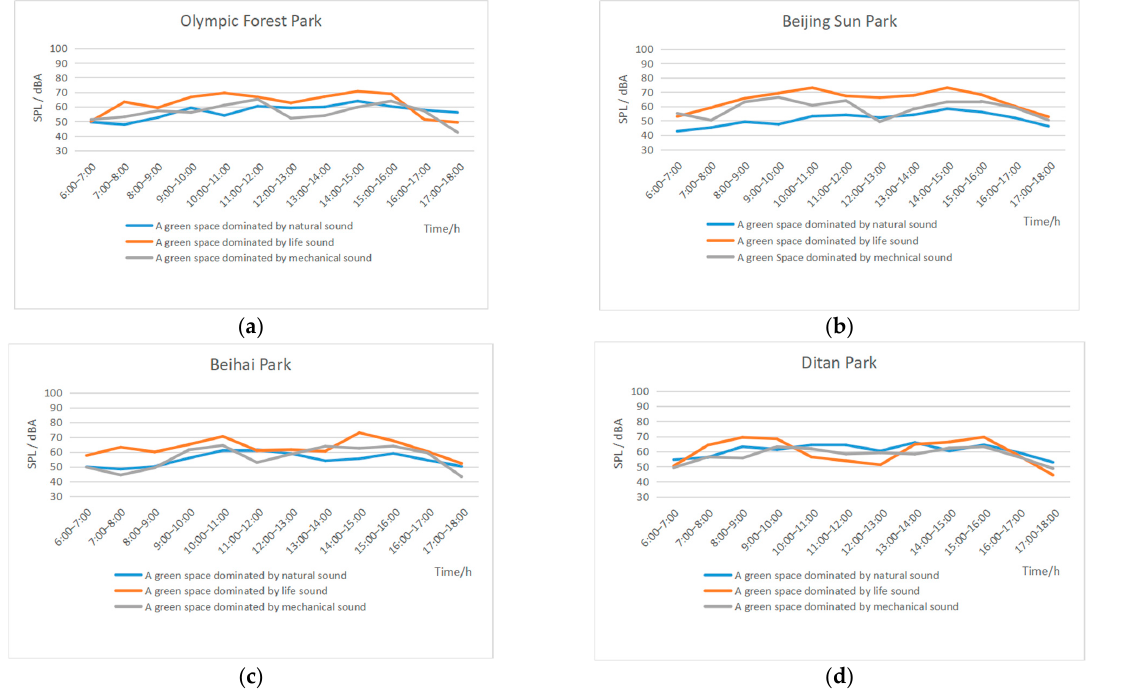
Figure 3. Trend diagram of sound pressure level in different time periods of various types of soundscape green spaces in four parks in summer. ( a ) Olympic Forest Park; ( b ) Beijing Sun Park; ( c ) Beihai Park; ( d ) Ditan Park. Notice: SPL represents Sound Pressure Level.